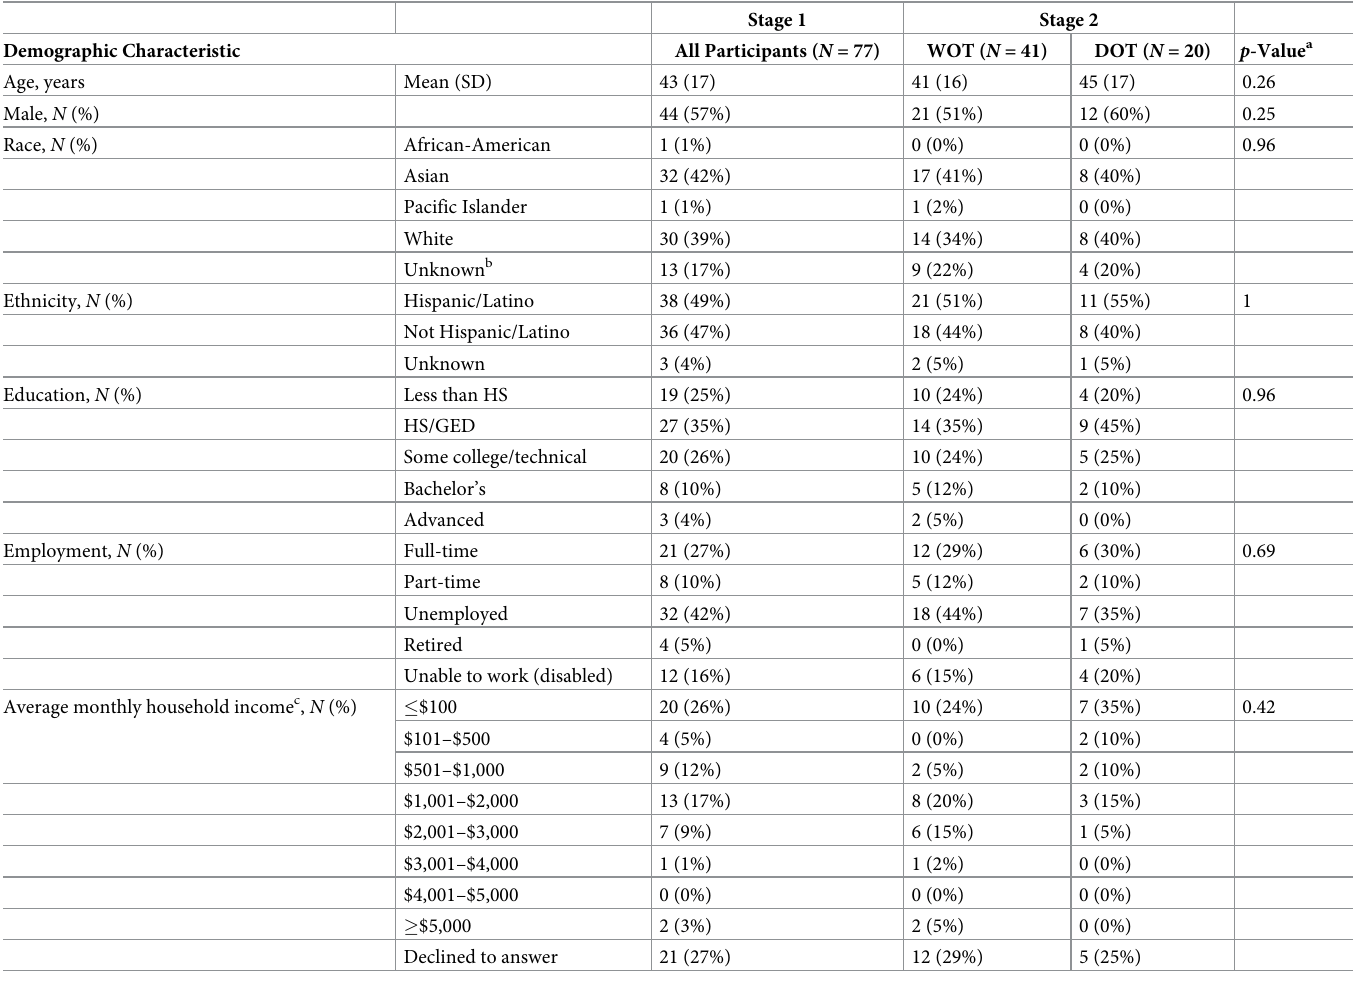
Table 1. Baseline demographic characteristics of participants enrolled in Stage 1 ( N = 77) and Stage 2 ( N = 61).